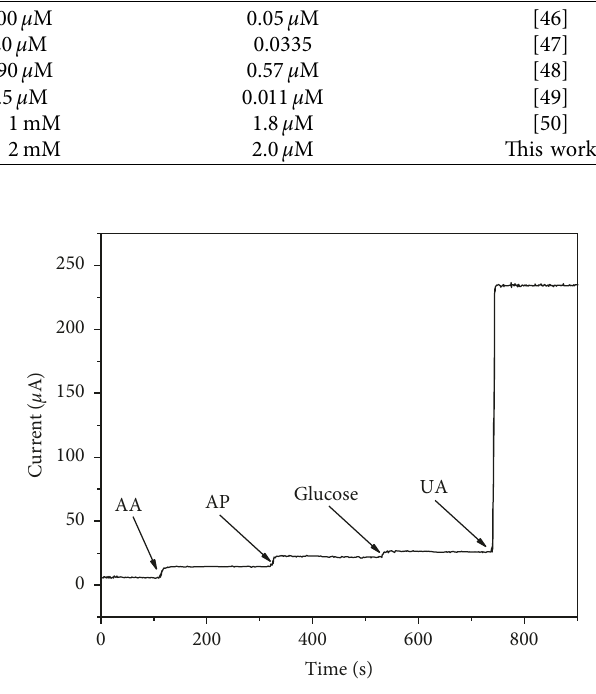
Figure 6: Amperometric response recorded using CuNW/SPCE towards UA and interference species (0.1M NaOH).